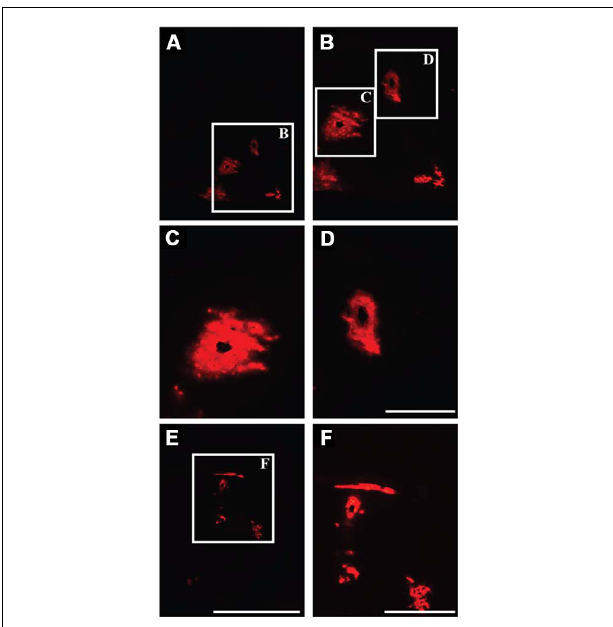
FIGURE 3 | Perivascular transport of liposomes. (A–F) Examination of parenchymal tissue 2 mm rostral from the site of infusion showing the presence of fluorescently labeled liposomes surrounding the lumen of blood vessels, indicating effective transport of these particles along perivascular spaces. Scale bars: A,E = 5 mm; C,D = 500 μ m; B,F = 1